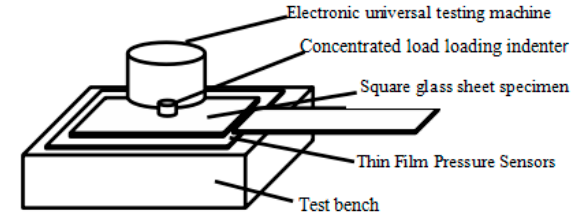
Figure 3. The schematic diagram of the test assembly.